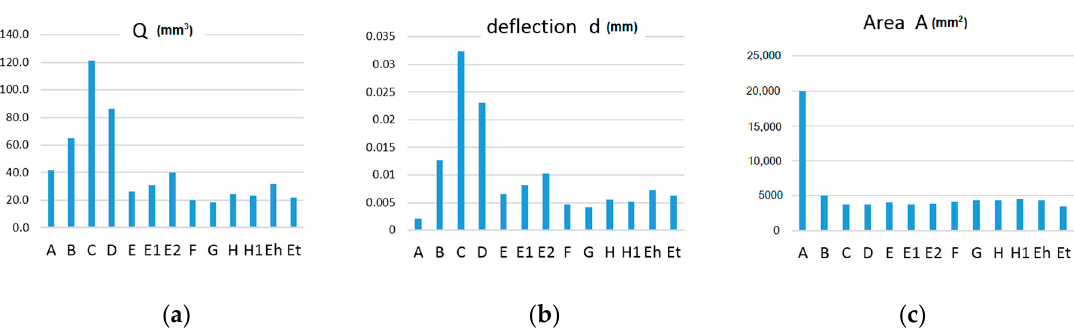
Figure 21. Comparison of shapes of individual beam and truss graphs of: ( a ) Q , ( b ) d and ( c ) A Figure21. Comparisonofshapesofindividualbeamandtrussgraphsof: ( a ) Q ,( b ) d and( c ) A parameters.